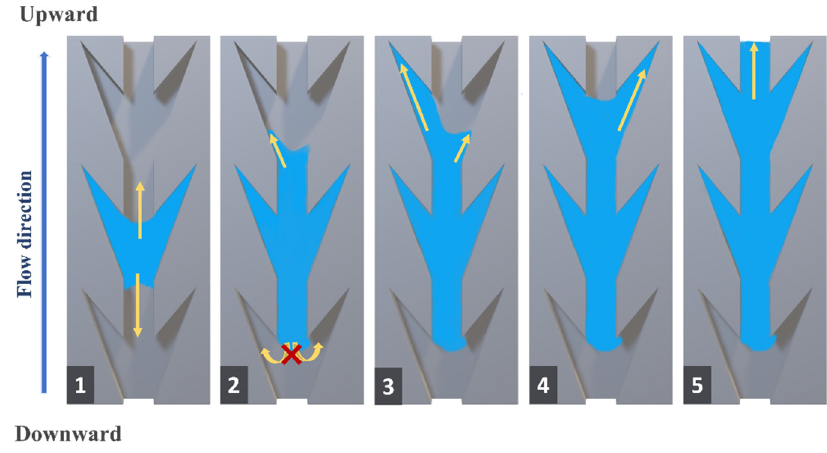
Figure 16. The illustration exhibits wetting mechanisms of dart-shaped structures for unidirectional wetting behavior.